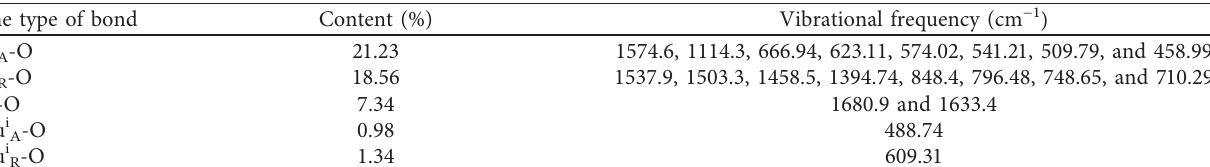
° C). (a) 400cm − 1 ∼ 1000cm − 1 ; (b) 2 samples at calcination temperature (550 2 samples with the content and vibrational frequency of valence bonds.